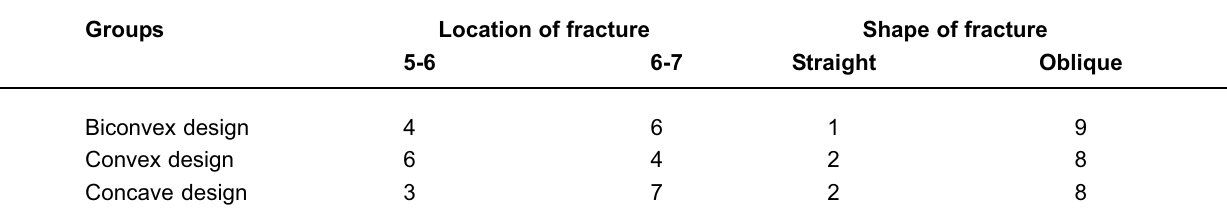
Different letters indicate statistically significant difference at 5% level TABLE 2 - The location and nature of fracture